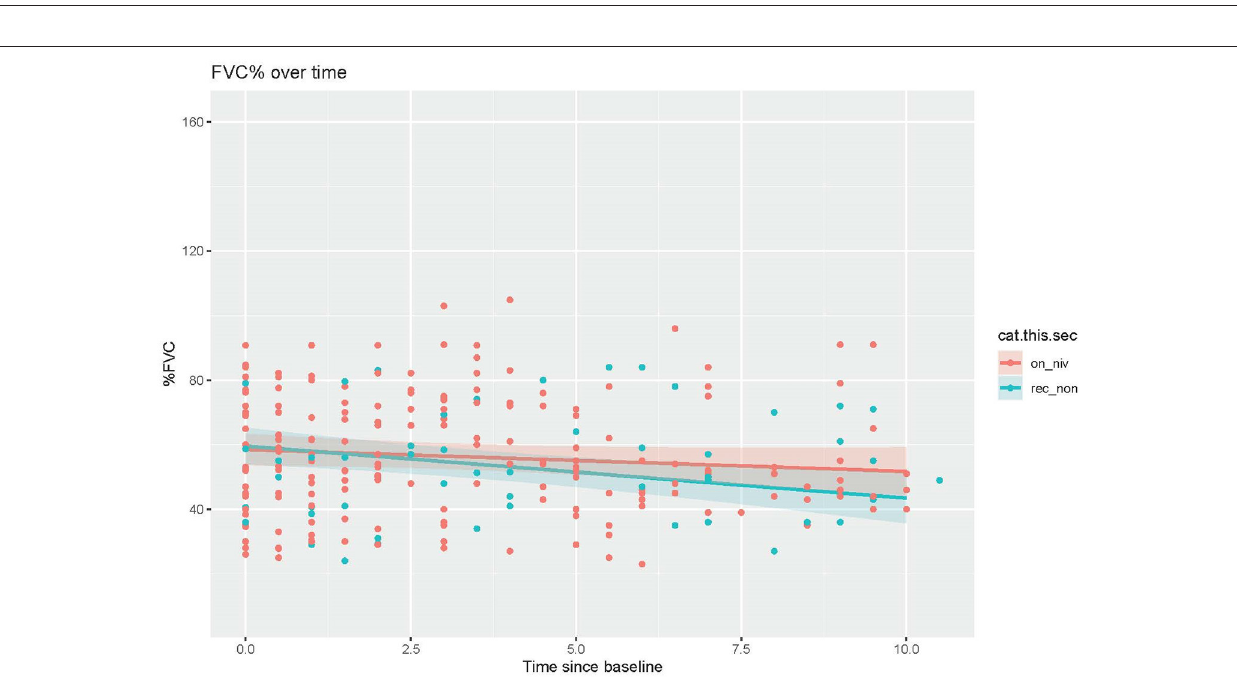
FIGURE 4 | Comparison of decline in percent predicted FVC over time between patients recommended but non-compliant with NIV vs. those on NIV ( t = − 2.319, p = 0.021).